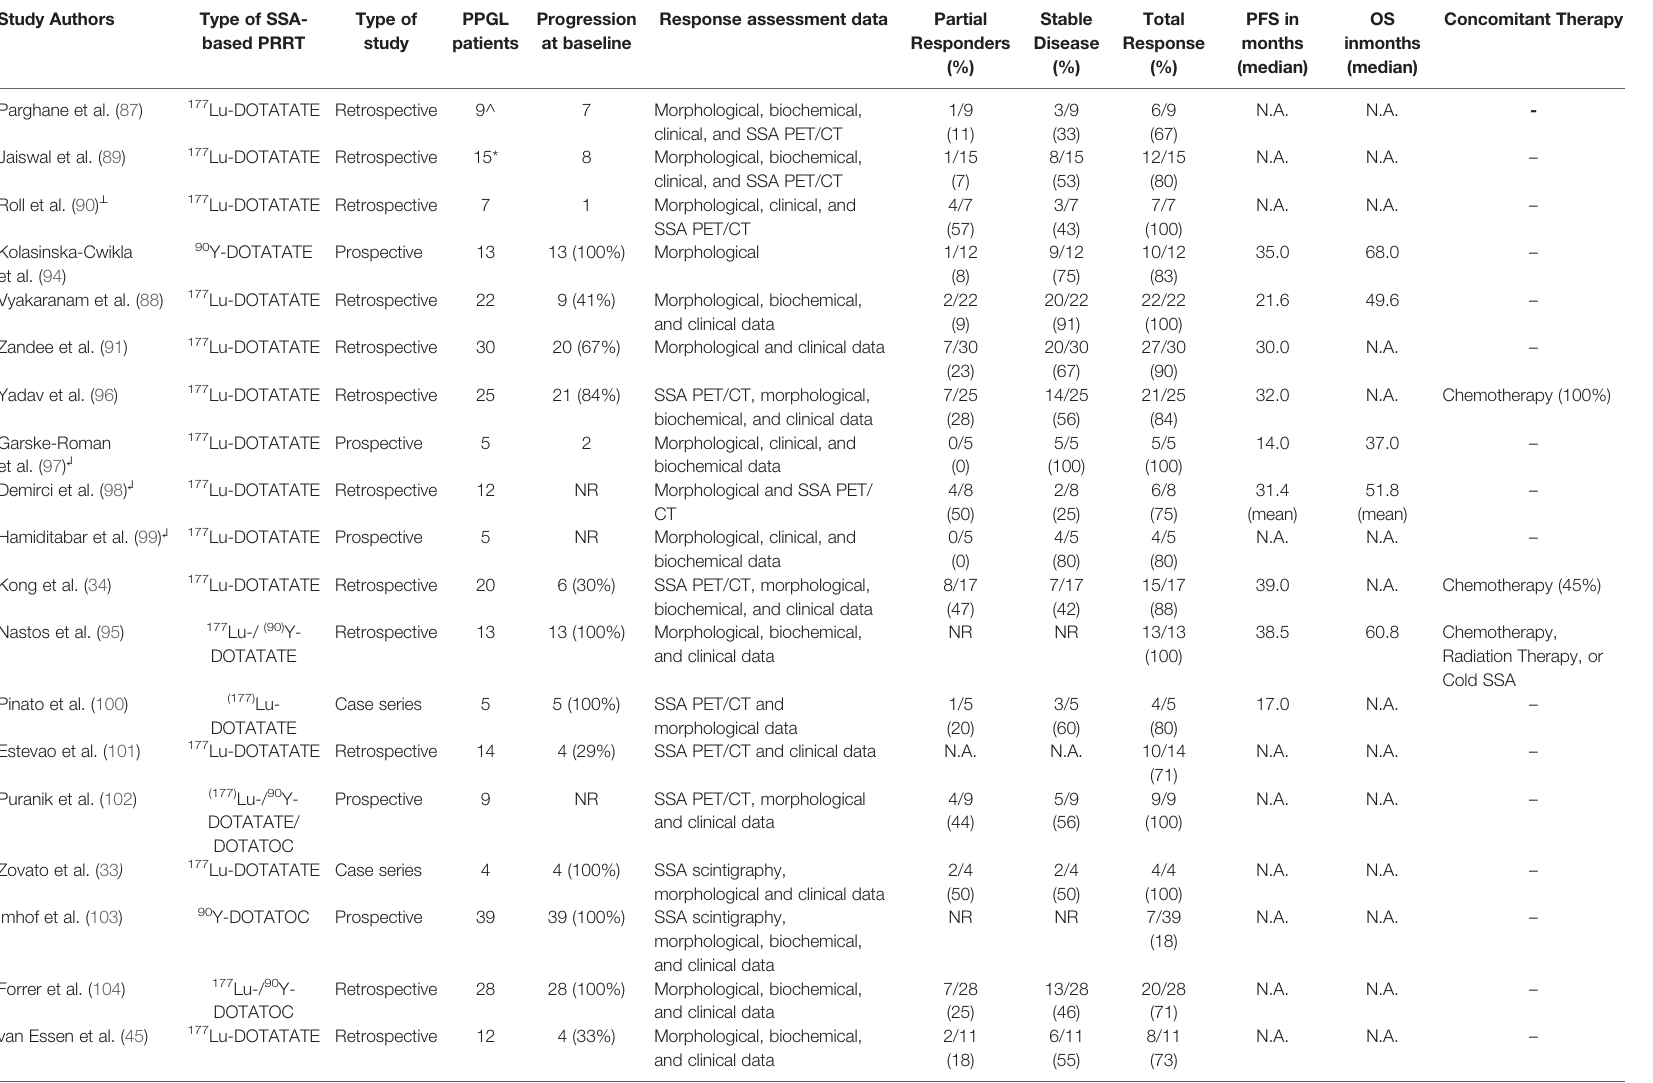
TABLE 1 | Somatostatin-based PRRT experiences with pheochromocytoma and paraganglioma in the order of year of publication (2020 to